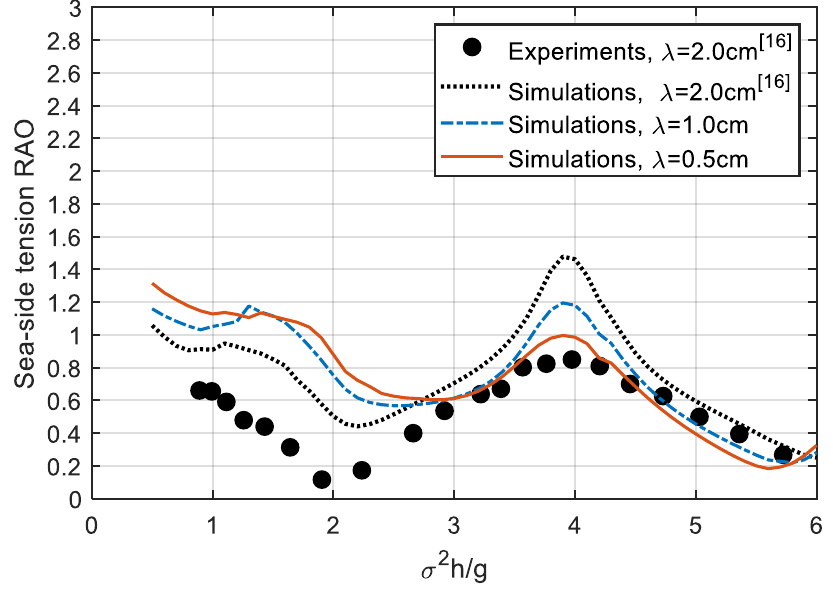
Figure 5. Comparison of the sea-side tension RAO for the platform with various fishnet mesh sizes.